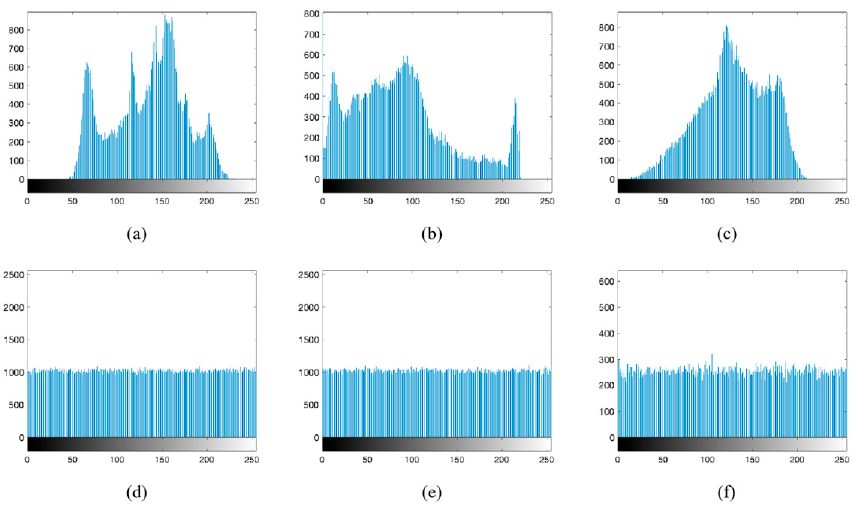
Figure 17. Histogram of each component before and after images of 256 × 256: ( a – c ) Histogram of images of 256 × 256; ( d – f ) Histogram of encrypted images of 256 × 256. Table 9. Security and performance analysis of color image.